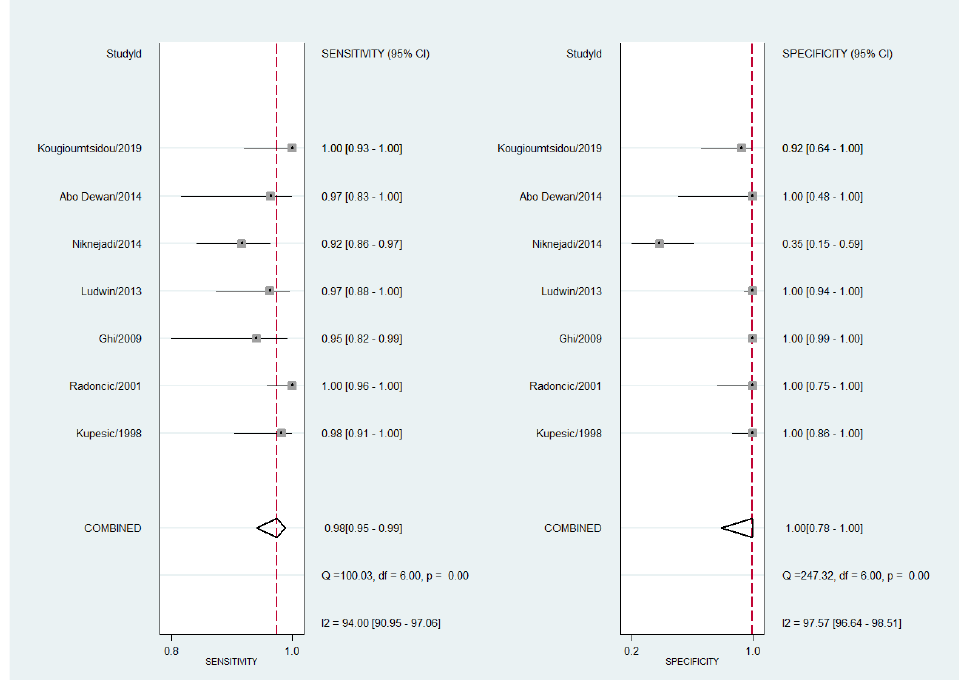
Figure 10. Forest plot for sensitivity and specificity for all studies concerning the diagnostic performance of three-dimensional transvaginal ultrasonography for uterine septum detection [13,24,25,30,34,35,38].